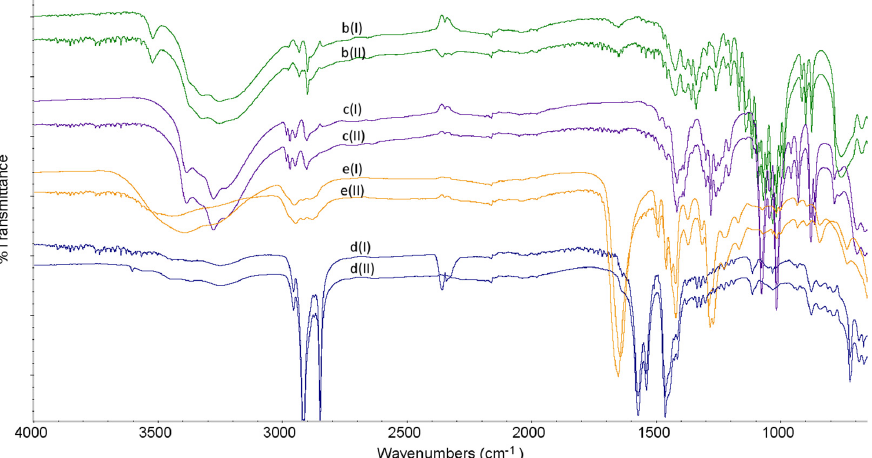
Figure 5. FT-IR spectra for lactose (b), mannitol (c), magnesium stearate (d) and polyvinylpyrrolidone (e) in the non-stressed (I) and stressed (II) samples.